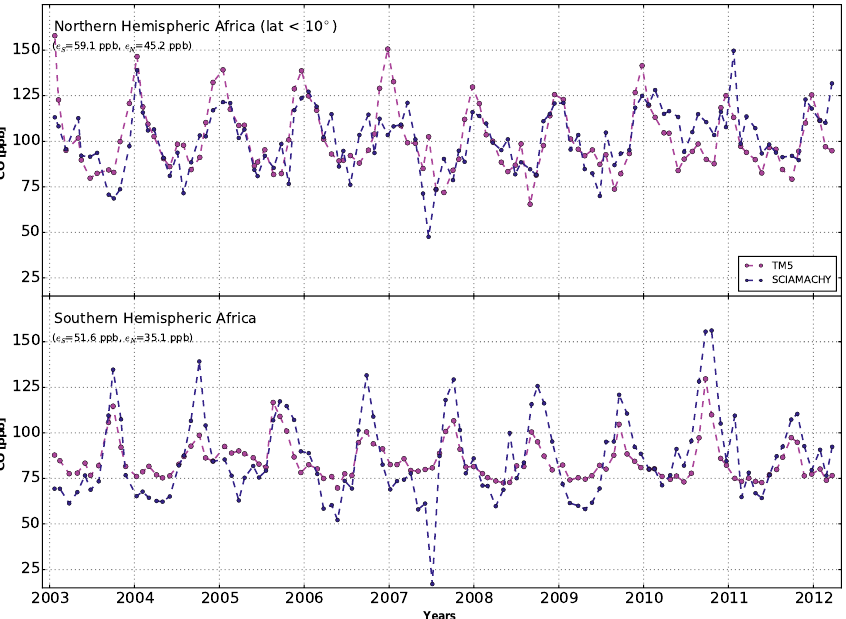
Figure 12. Time series of SCIAMACHY CO wet air column averaged mixing ratios (blue) over northern and southern hemispheric Africa compared with the calculation of the TM5 model (pink); 30-day medians are